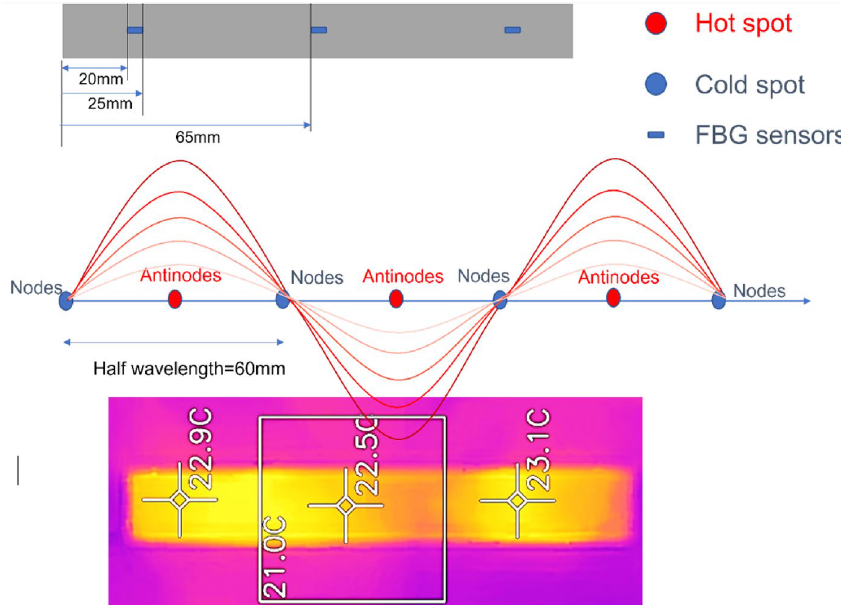
Figure 21. Schematic illustration of (above) the location of FBGs on the sa mple surface, and (below) standing waves formed in a microwave oven showing hot spots (antinodes) and cold spots